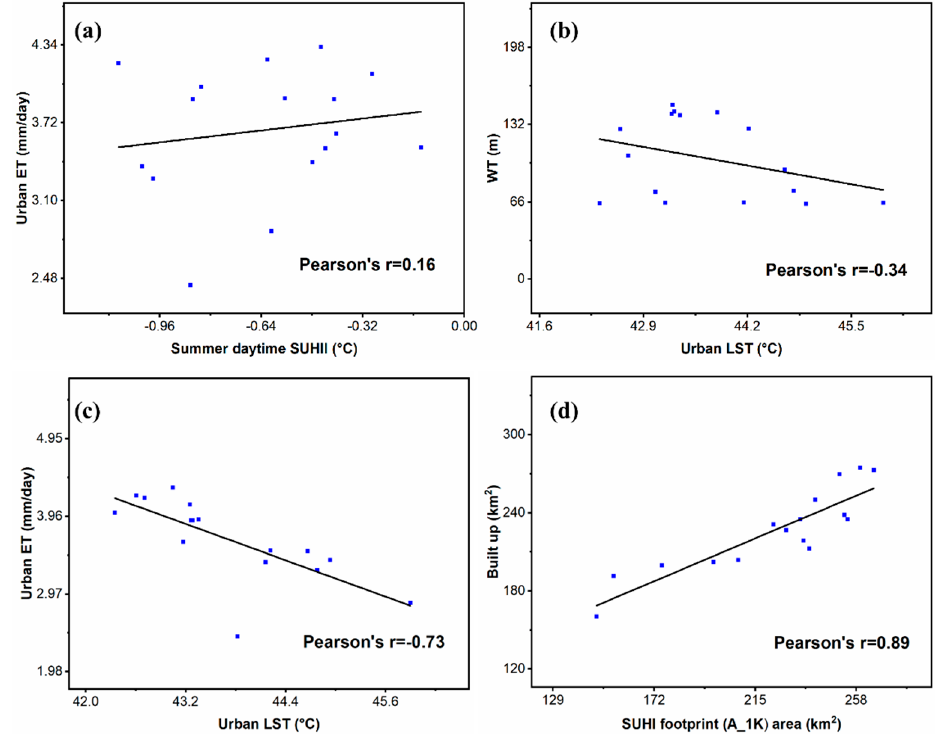
Figure 12. Summer season: scatterplot between ( a ) urban ET and daytime SUHII, ( b ) WT and daytime urban LST, ( c ) urban ET and daytime urban LST, and ( d ) built-up area and SUHI footprint area A_1K.